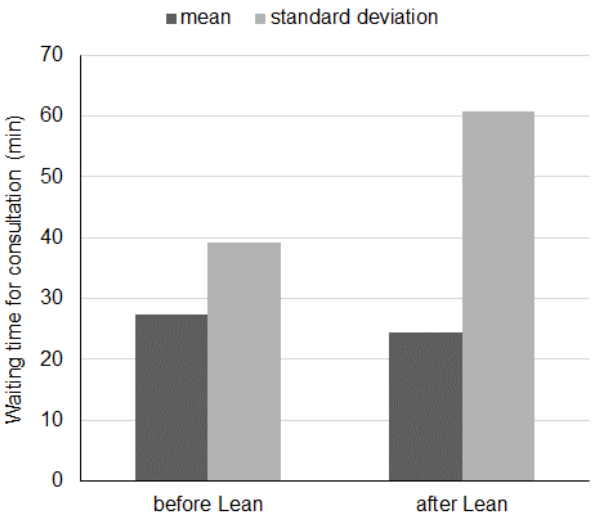
Figure 5. Comparison of average waiting times for consultations before and after improvement.